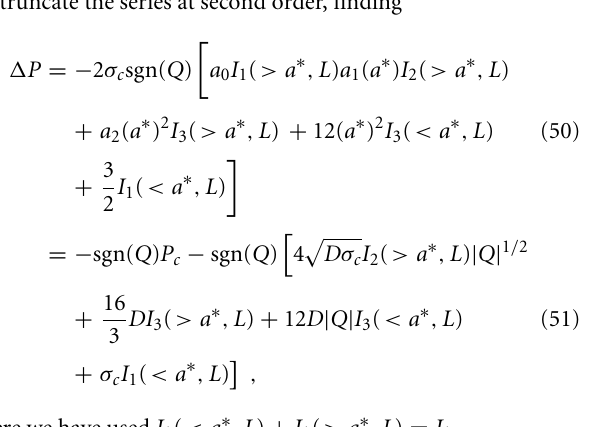
the figure runs over 11 orders of magnitude in a , this region may seem narrow in the figures. Bottom: The integrals have been rescaled by a kH − 1 I k ( a , L ) in order to bring out the scaling regions more clearly. The region where we see scaling according to Equation (42) now appears horizontal. We have chosen H = 0 .